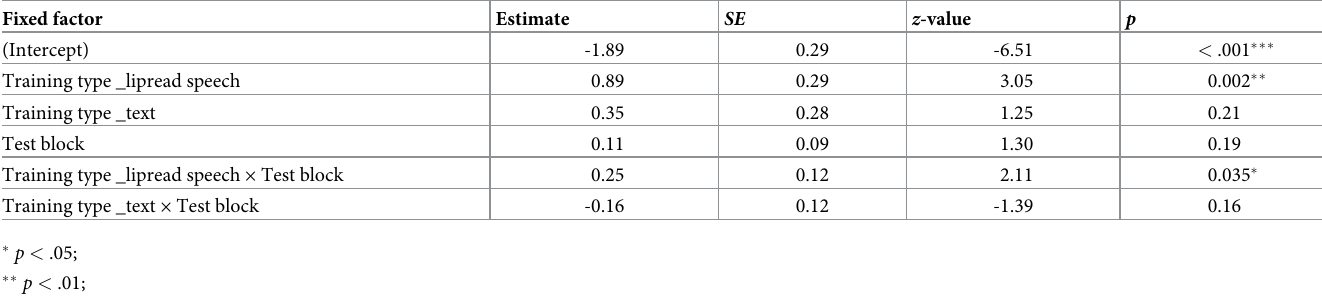
Table 3. Fixed effect coefficient estimates for the generalized linear mixed effects model fitted on the auditory-only follow-up test data. Correct ~ 1 + Training type × Test block + (1 | subject) + (1 | item). Fixed